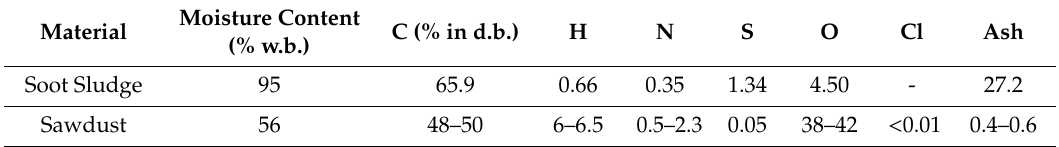
Table 1. Ultimate analysis of soot sludge and sawdust [5].